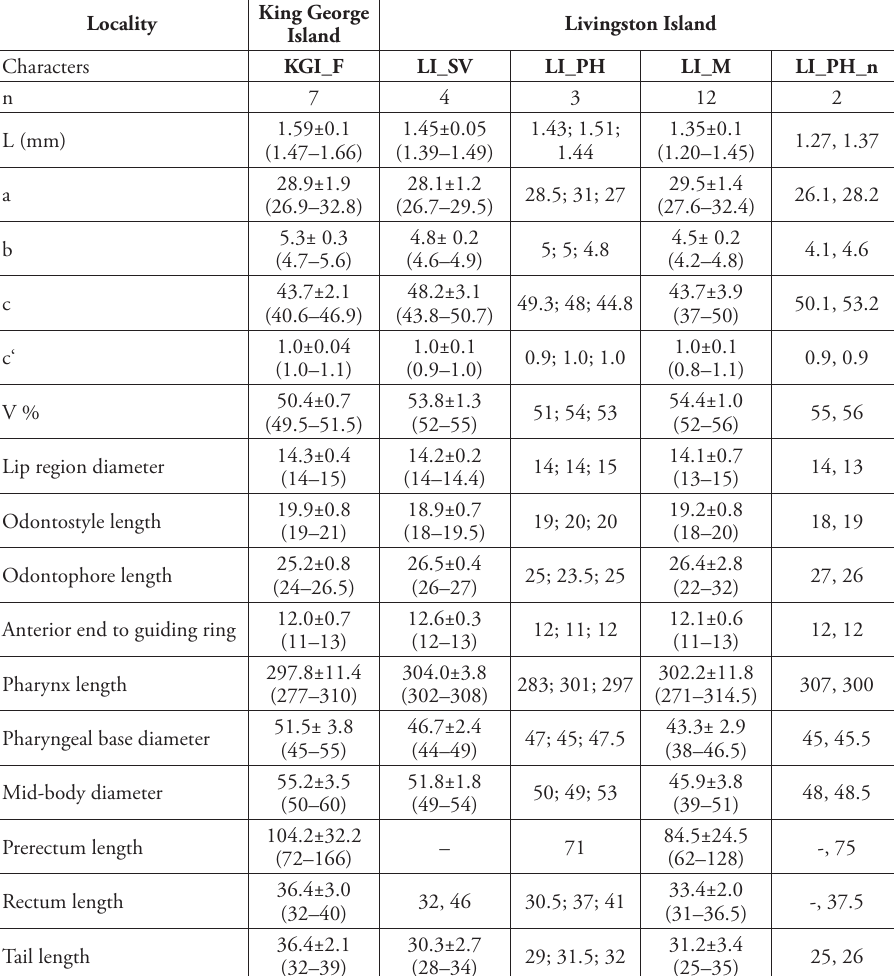
Table 2. Morphometrics of Enchodeloides signyensis gen. n., comb. n. (females). All measurements, unless indicated otherwise, are in µm (and in the form: mean±SD